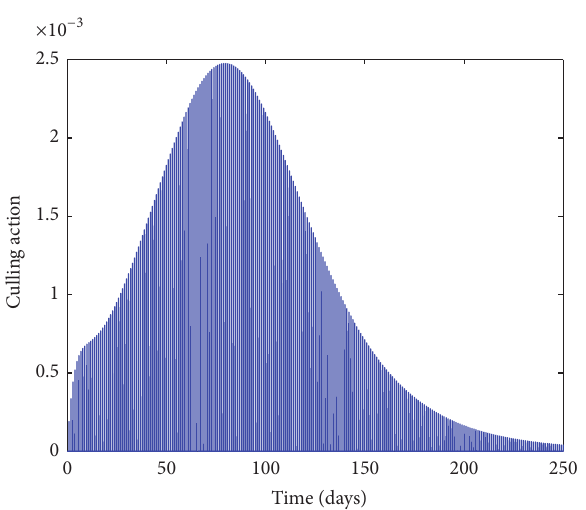
Figure 9: Culling effort 𝜌 𝐷 𝐷(𝑡) with a daily culling rate of 𝜌 𝐷 = 0.1 .